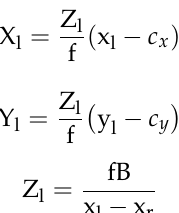
Figure 10. The schematic diagram of the binocular vision algorithm.